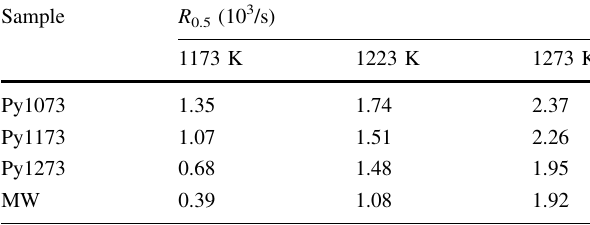
Table 3 Summary of reactivity index ( R 0.5 )